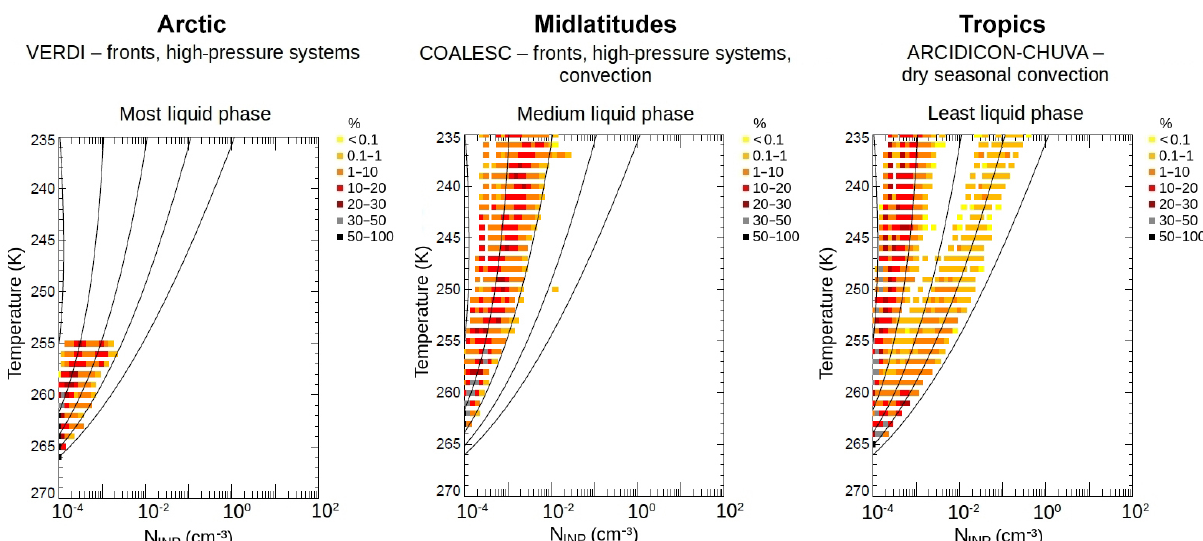
Figure 13. Frequencies of occurrence of INP concentrations ( N INP ) vs. temperature during VERDI (Arctic), COALESC (midlatitudes) and ACRIDICON–CHUVA (tropics). INP number concentrations are estimated via aerosol concentrations for particles > 0.6µm following DeMott et al. (2010). The black lines indicate INP concentrations for constant aerosol concentrations of 0.01 (leftmost line), 0.1, 1, 10 and 100cm − 3 (rightmost line).